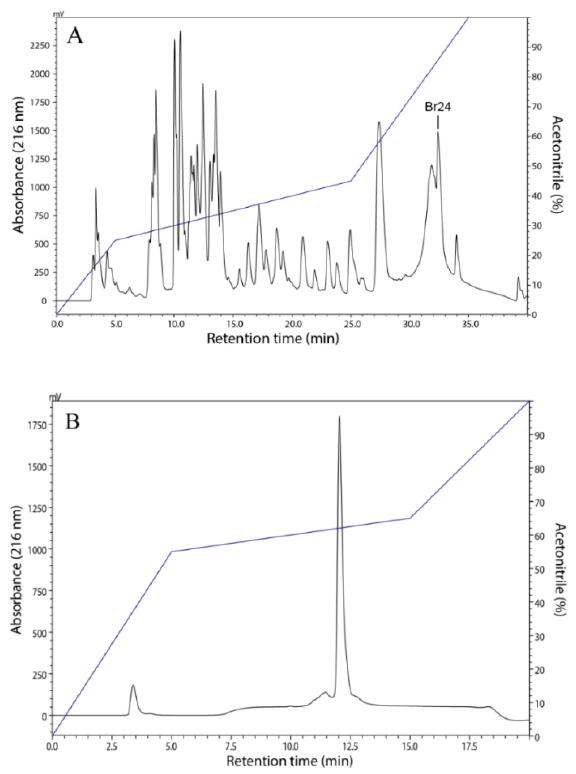
Figure 1. ( A ) Reversed-phase HPLC profile of B. raniceps skin secretion fractionated on a Vydac C 8 column. One antibacterial fraction is indicated as Br24. The blue line shows the concentration of solution B (acetonitrile + TFA 0.1%, v / v ). ( B ) Purification of the antimicrobial peptide (present in Br24 fraction) on a Shim-pack VP-ODS C 18 column.